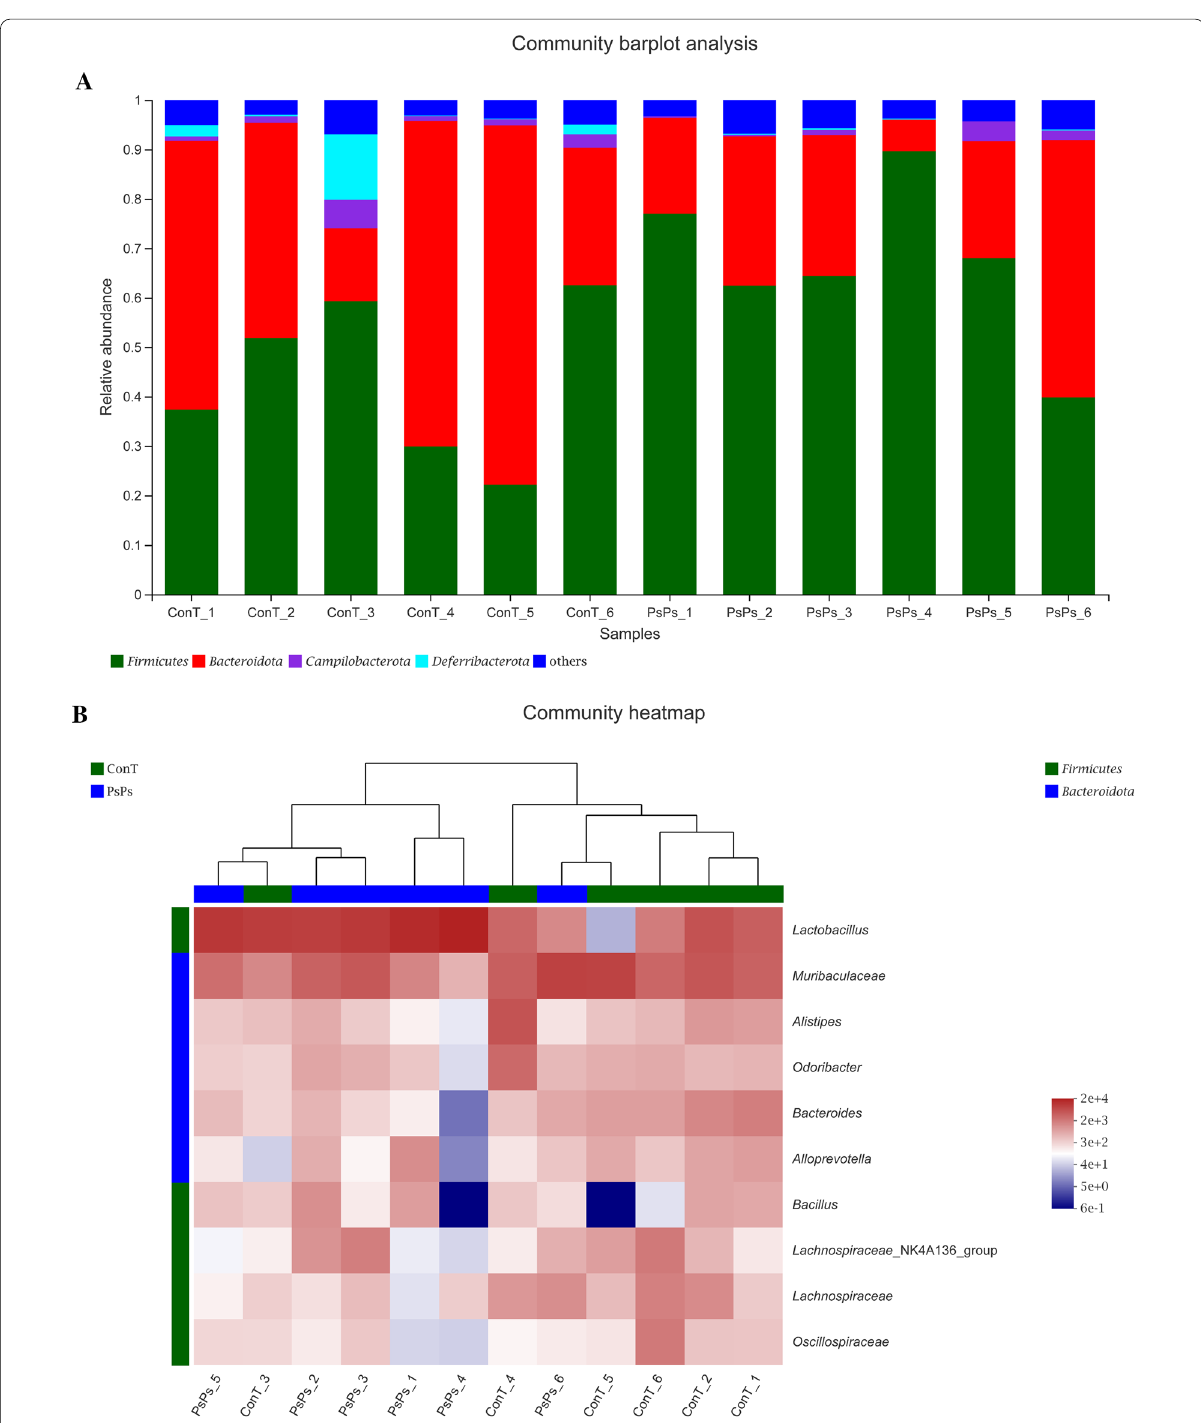
Fig. 1 Regulation of polysaccharide on intestinal microflora composition in mice. A Relative abundance of intestinal flora at phylum level. B Classification heat map of intestinal flora at genus